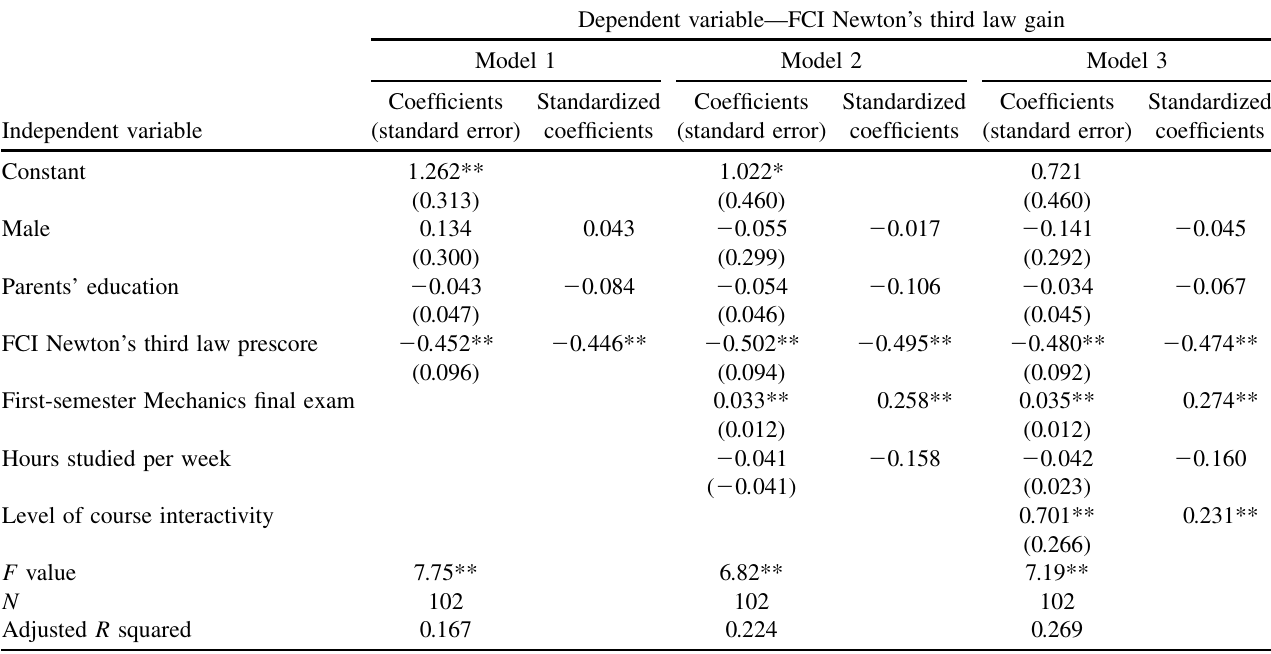
TABLE III. FCI Newton’s third law—Models 1–3 (* p < 0 : 05 , ** p < 0 : 01